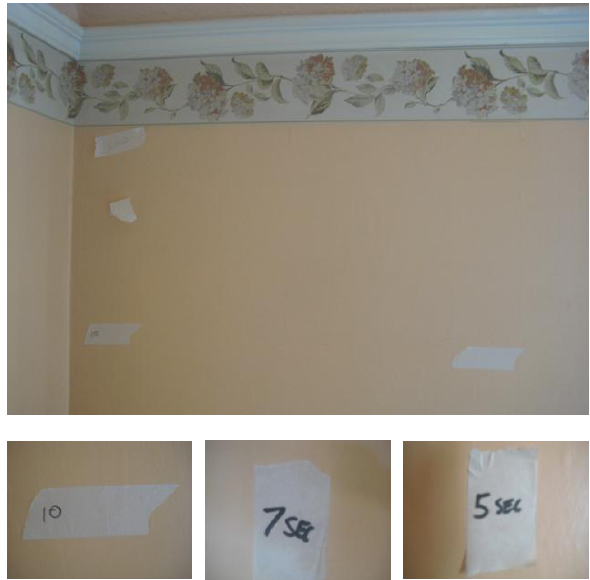
Figure 15. Alternation of bays and localisation of the foam level on the